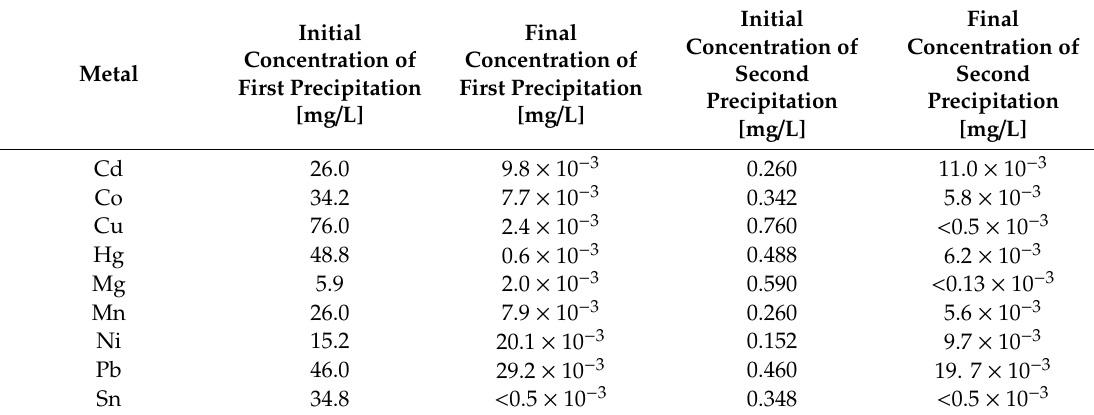
Table 6. Final metal concentrations achieved by sulphide